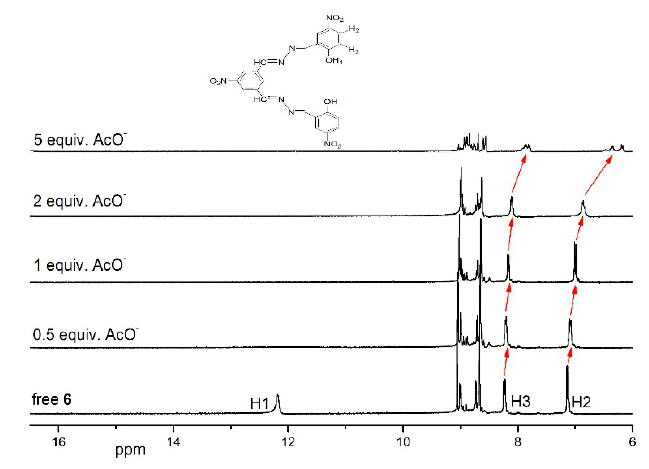
Figure 5. 1 H-NMR spectra of compound 6 in DMSO- d 6 (1 × 10 − 2 mol·L − 1 ) with addition of molar equivalent of AcO − .